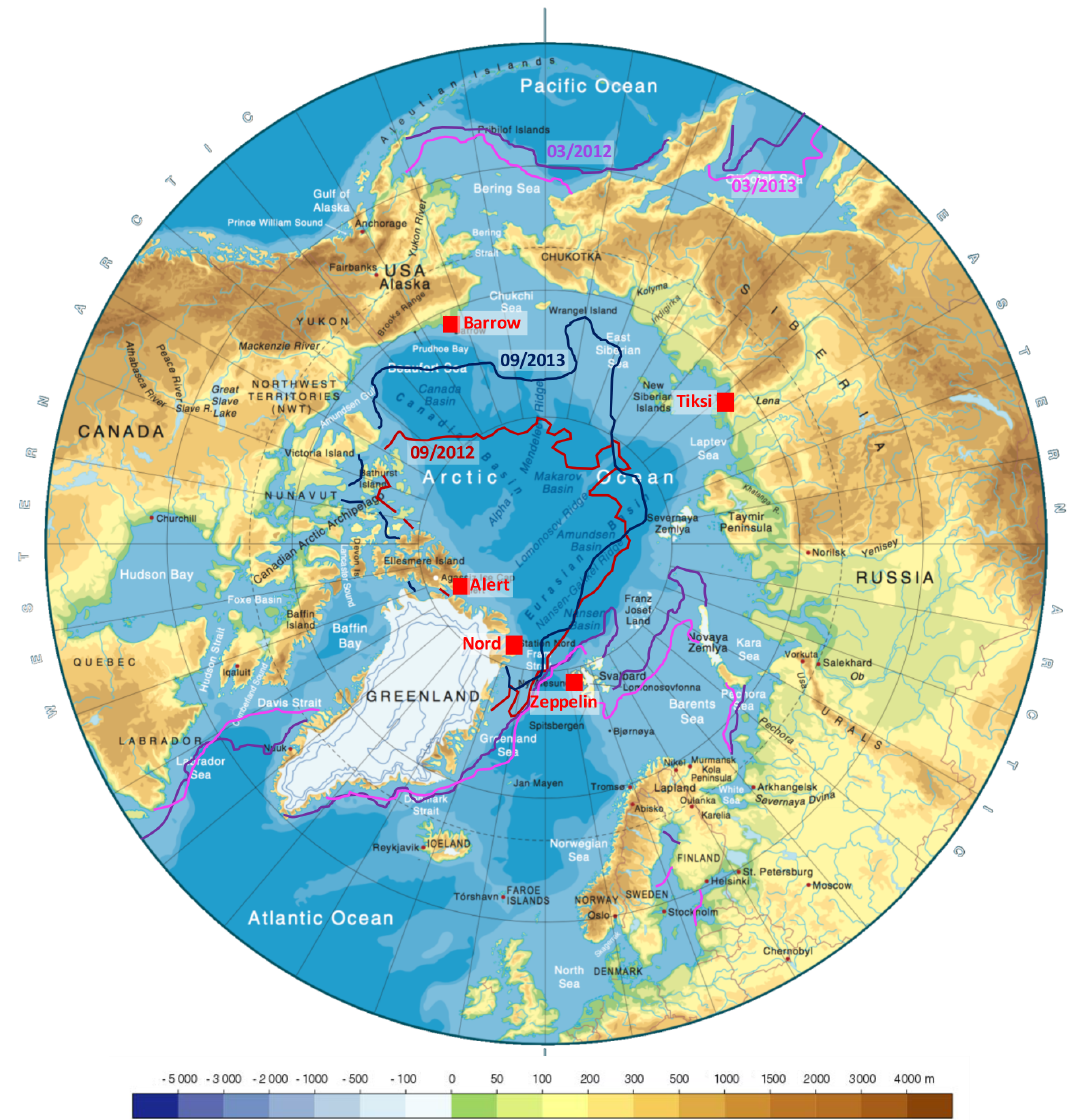
Figure 1. A physical map of the Arctic region, with the five aerosol measurement sites marked with red squares around the Arctic Ocean. The curved lines indicate the areal extent of the satellite-derived minimum and maximum ice edge in 2012 and 2013, which occurred in September and March, respectively. Here, the ice edge is defined as where the ice concentration is